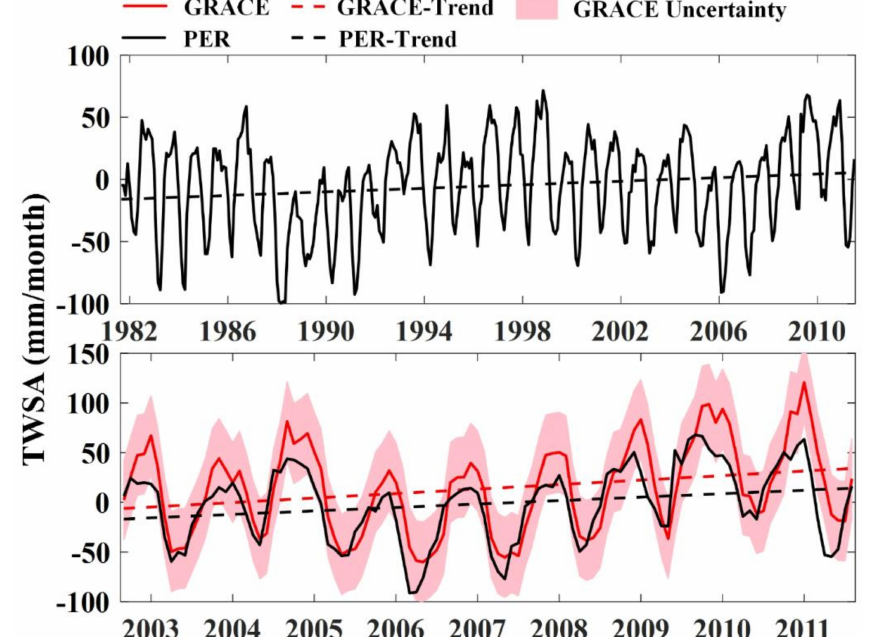
Figure 11. Time series of the total water storage anomaly (TWSA) retrievals over the Mississippi River Basin (MRB) from 1982 to 2011 (top). Comparison of the TWSA estimates with those of the Gravity Recovery and Climate Experiment (GRACE) from 2003 to 2011